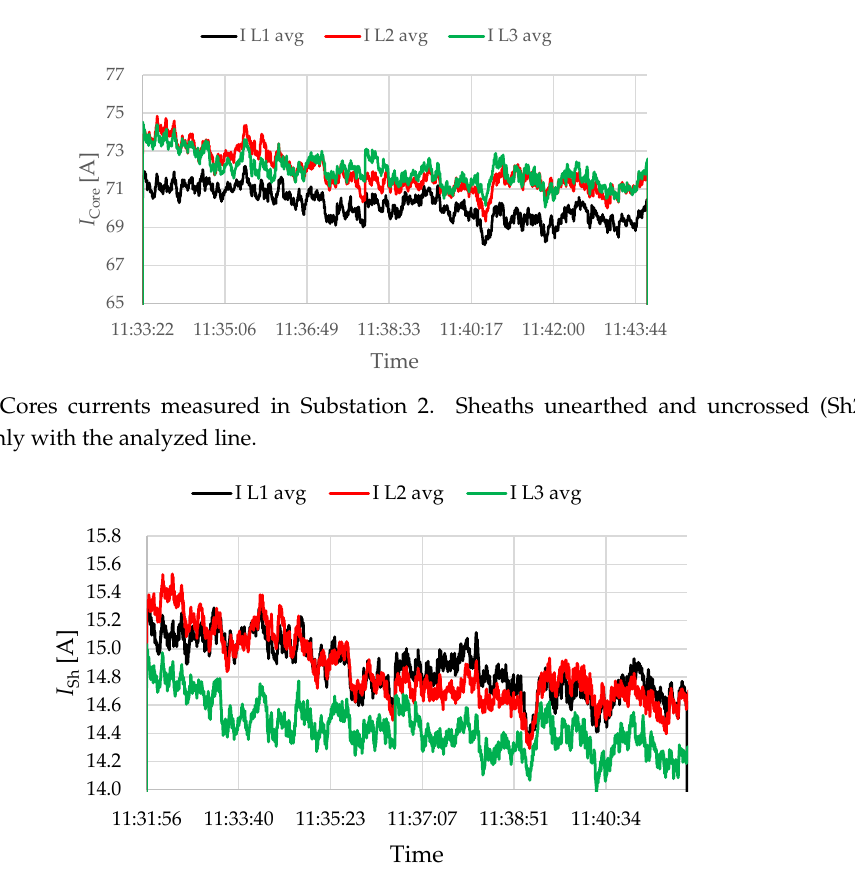
Figure 13. Sheaths voltages measured in Substation 2. Sheaths unearthed and uncrossed (Sh2). Operation only with the analyzed line.